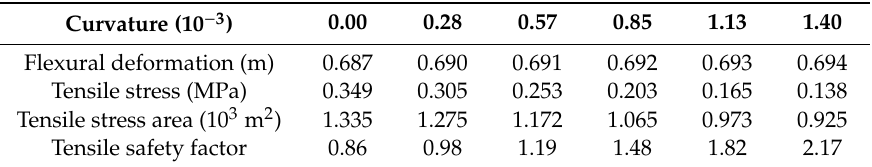
Figure 32. Relationship between tensile stress area maximum of CACC and curvature of CACC. Table 9. Flexural deformation, tensile stress, tensile stress area, and tensile safety factor of CACC with di ff erent curvatures of